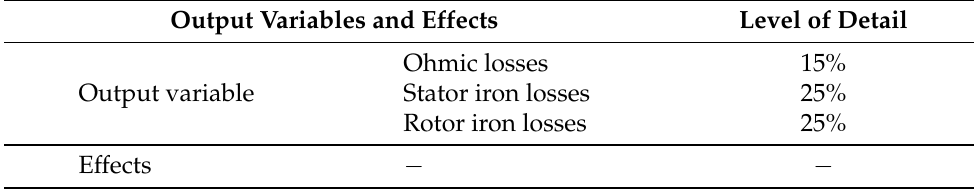
Table 3. Output variables of the machine model to be investigated.